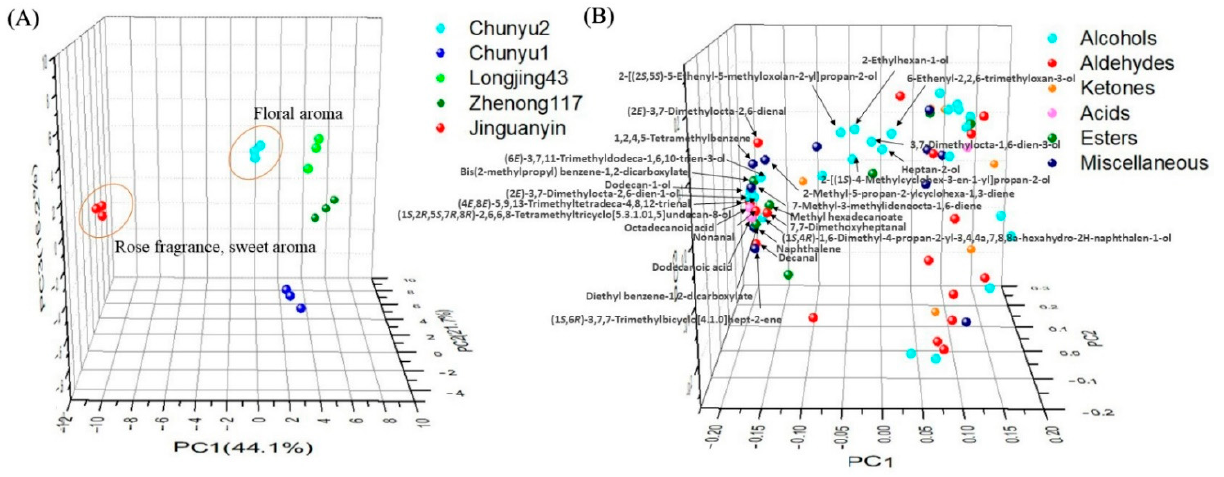
Figure 5. The PCA result of black tea samples from different tea cultivars based on the volatile compositions. ( A ) score plot; ( B ) loading plot. The number of replicates is equal to 3.